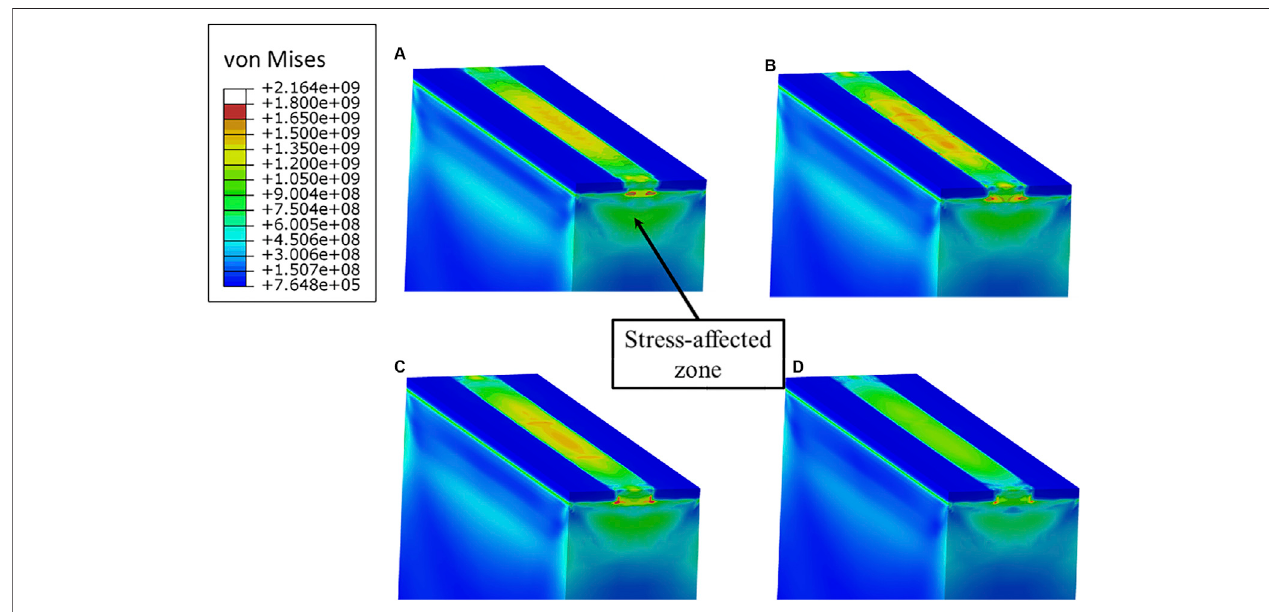
FIGURE 6 | Von Mises stress (Pa) distributions for the (A) ED and (B) HL ( τ (cid:2) 5), (C) HL ( τ (cid:2) 10), (D) HL ( τ (cid:2) 20) models after cooling (10 s) and relaxing the part constraints. The laser power is 200 W, and the speed is 1,000 mm/s for all four images.